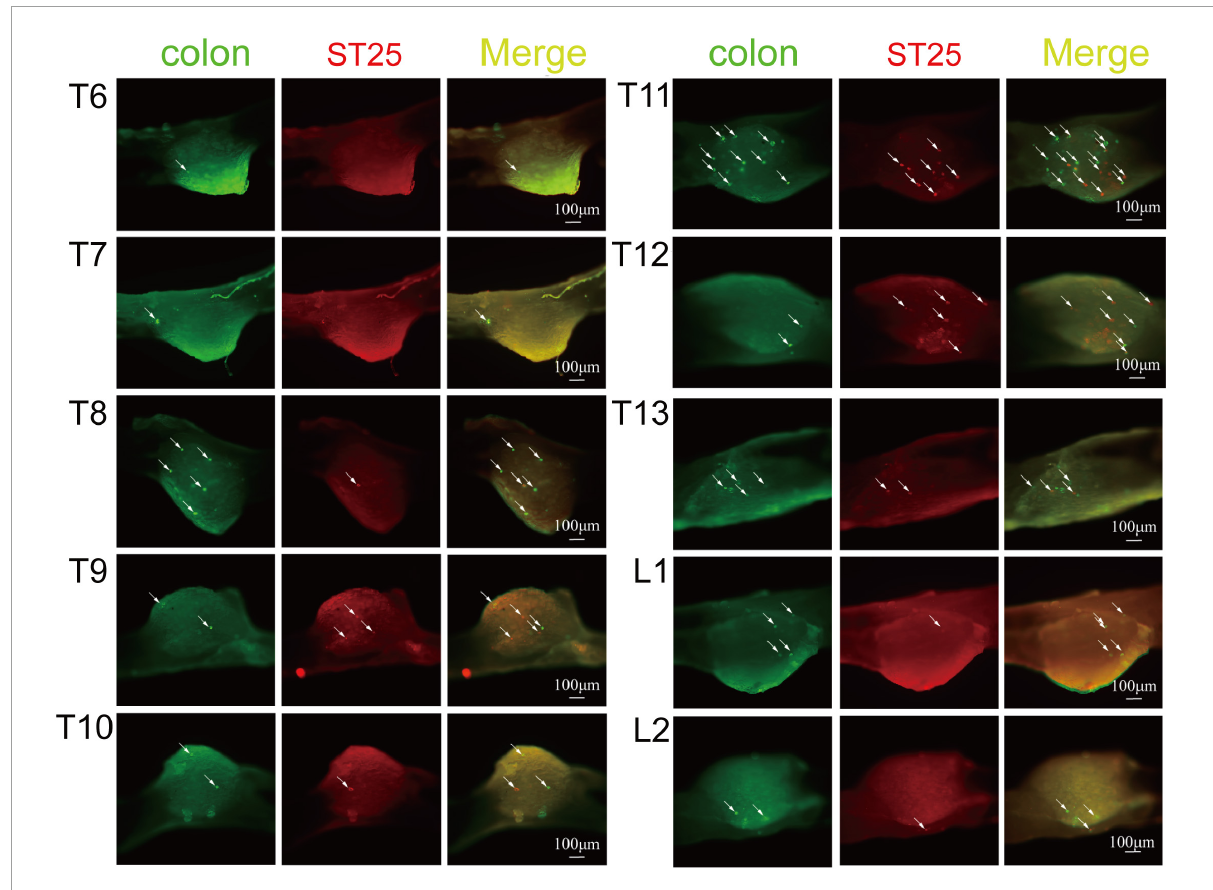
FIGURE4 The positive labeling of dorsal root ganglia (DRGs) (not sectioned) under fluorescence microscopy. Representative photomicrographs showing the distribution of AF488/594-CTB-labeled sensory neurons in T6–L2 DRGs.